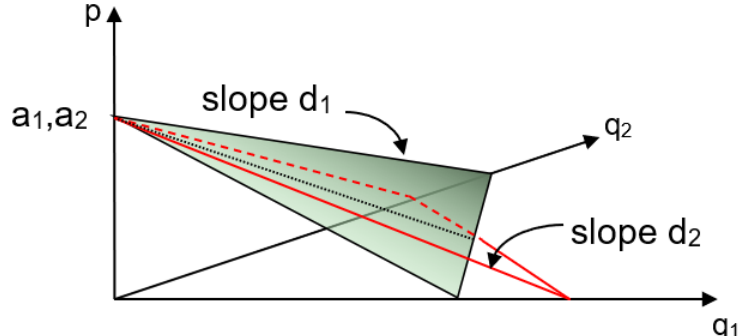
Figure 1. Indirect demand function for differentiated duopoly.